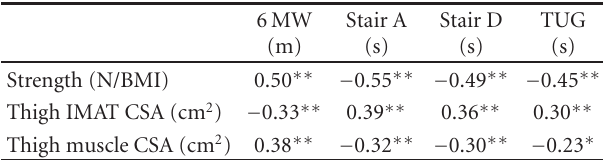
Table 2: Bivariate correlations between muscle and mobility vari- ables. Intramuscular adipose tissue (IMAT), cross-sectional area (CSA), six minute walk (6MW), stair ascent (stair A), stair descent (stair D), timed up and go